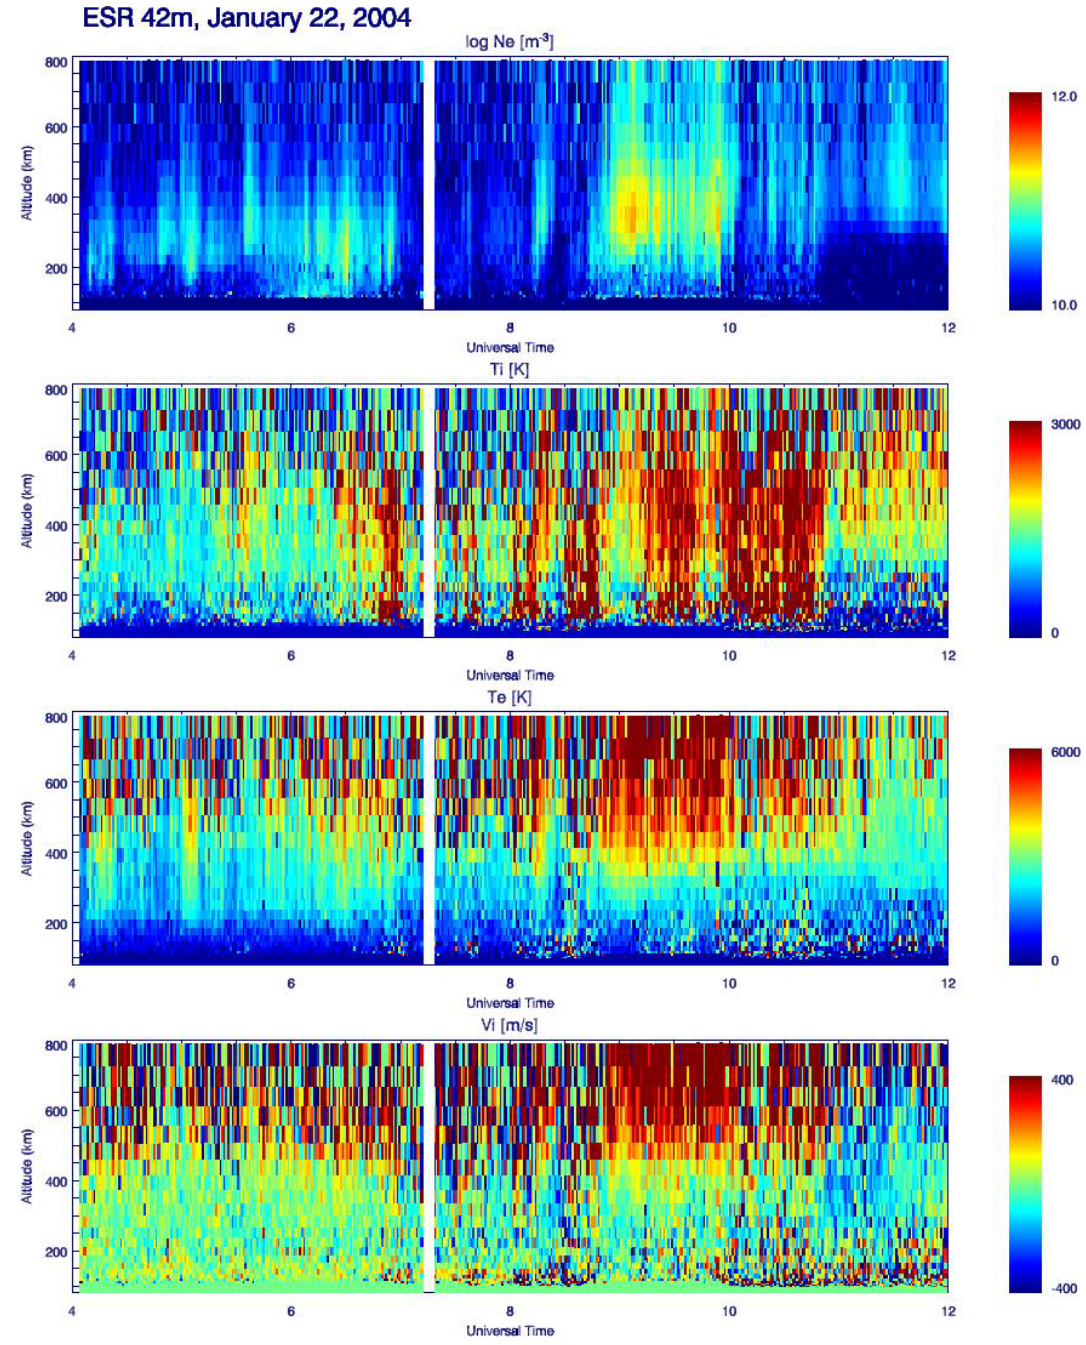
Fig. 3. A standard analysis of the ESR data where the panels show from the top to the bottom: the electron density, the electron temperature, the ion temperature and the ion drift velocity.